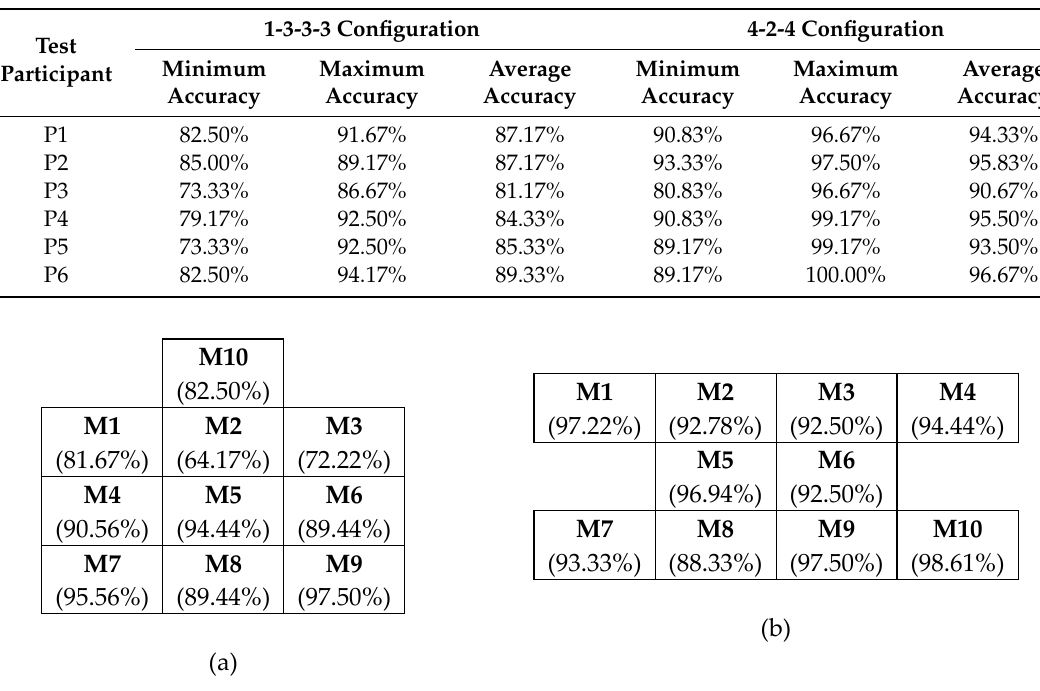
Figure 8. Accuracy of identifying individual motor signals: ( a ) 1-3-3-3 configuration; ( b ) 4-2-4 configuration.